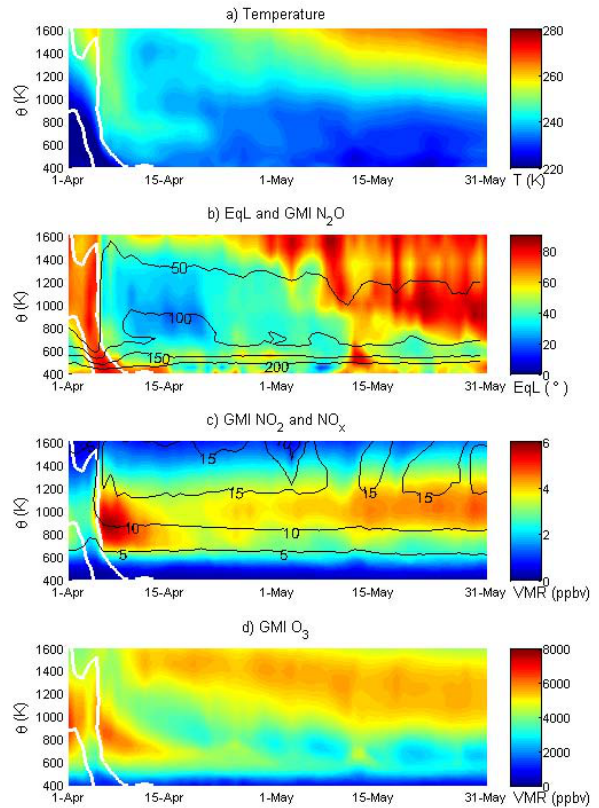
Fig. 3. Time-potential temperature plots above Eureka for April/May 2011. (a) Temperature (K) from GEOS-5 DMPs. (b) EqL ( ◦ ) (color-scale) from GEOS-5 DMPs and N 2 O VMR (black contour lines, with labels given in ppbv) from GMI. (c) NO 2 VMR (color-scale in ppbv) and NO x VMR (black contour lines, with la- bels given in ppbv) from GMI. (d) Ozone VMR (ppbv) from GMI. Low [high] temperatures, EqLs, and VMRs are given in blue [red]. Thick white lines indicate boundaries of the polar vortex determined by sPV = 1 . 6 × 10 − 4 s − 1 .